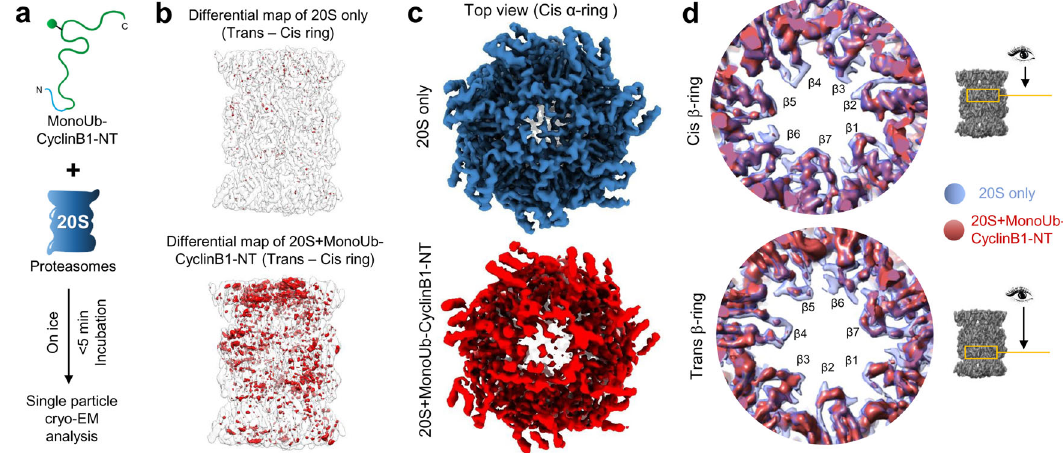
Fig. 4 Conjugated MonoUb-Cyclin B1-NT induces structural alterations to the 20S proteasome. a The model depicts the work- fl ow of sample preparation for cryo-EM: MonoUb-Cyclin B1-NT was incubated brie fl y with puri fi ed 20S proteasomes at 1:5 (proteasome:substrate) molar ratio on ice, frozen within 5 min, and then vitri fi ed for further cryo-EM single-particle analysis. b Difference map rendering the symmetric pattern between the trans - and cis -rings of the 20S-alone map (upper) and 20S + monoUb-Cyclin B1-NT map (lower). The difference map (red density) was generated by using a 180° rotated (around the pseudo twofold axis) map minus its original unrotated map (transparent gray). c The top view of density maps from the cis α -ring of 20S only (blue) and the S1 class of 20S + monoUb-CyclinB11-NT (brick red) dataset. d Comparison of the 20S-alone (transparent blue) and the S1 class of 20S + MonoUb-Cyclin B1-NT (brick red) maps in the two β -rings focused on the β -annulus regions. Note the density loss in some of the annulus loops or β -sheet regions exposed to or close to the catalytic chamber in both β